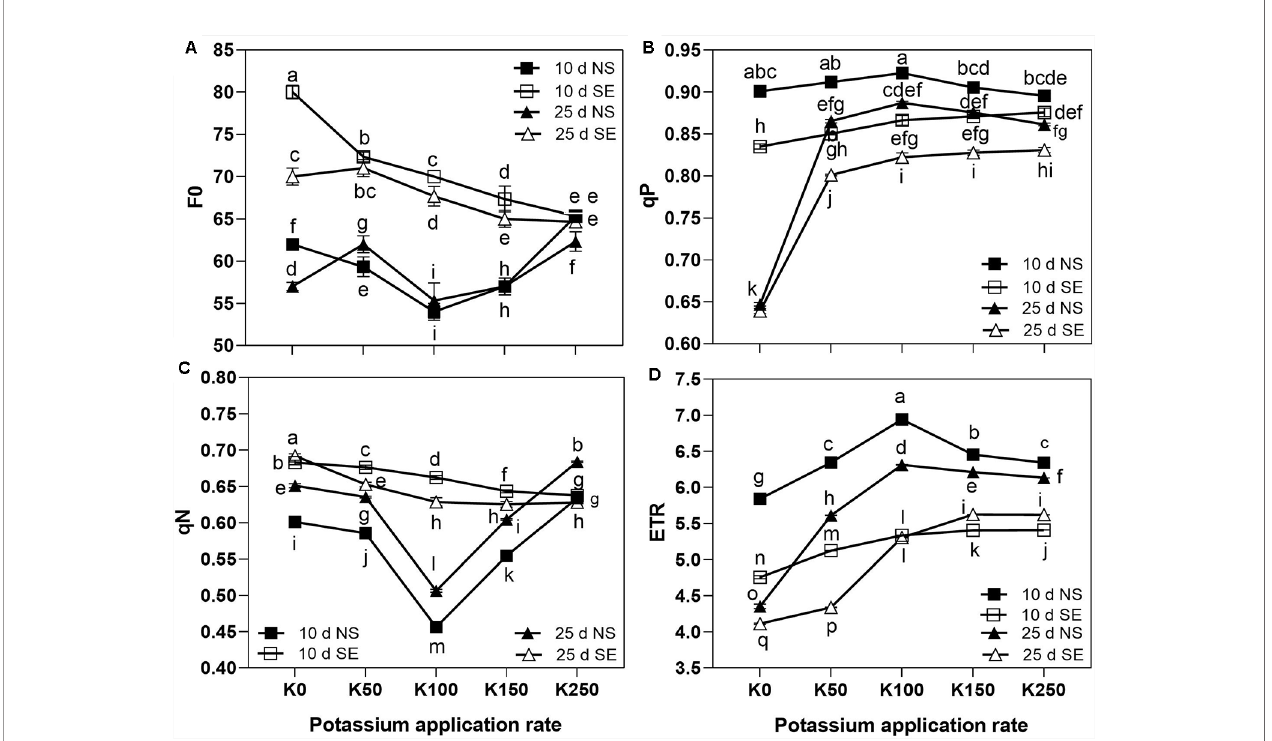
FIGURE 3 | The chlorophyll fl uorescence characteristics of winter wheat fl ag leaves under different treatments. The error bars stand for standard deviations of the means of fi ve independent biological replicates. For each trait, different letters represent signi fi cant difference from each other according to three-way repeated measures ANOVA followed by least signi fi cant difference (LSD) multiple comparison (P < 0.05) . NS: no shading treatment; SE: shading from the 1st day to the 10th day after anthesis (shading at early fi lling stage for 10 days, SE); Five potassium rate: 0 (K0), 50 (K50), 100 (K100), 150 (K150), and 250 (K250) mg K 2 O kg -1 soil in the form of